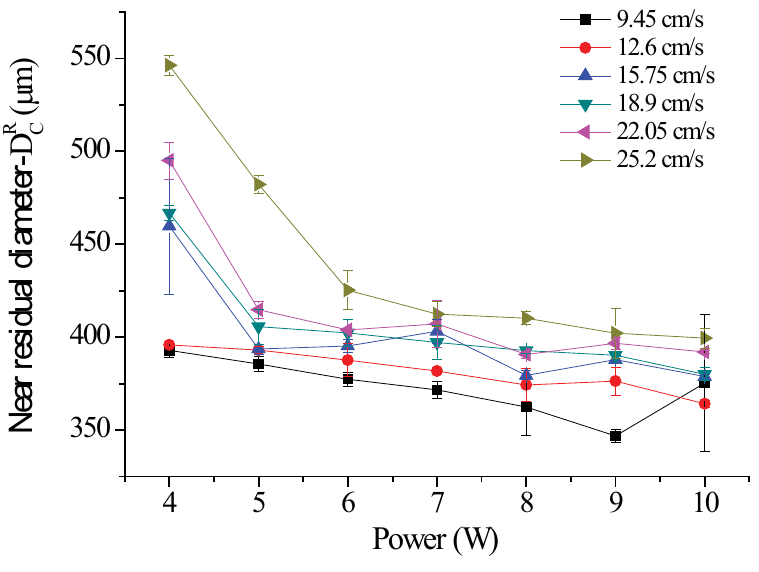
Figure 15. Schematic of the size analysis results (Scanning path: parallel).